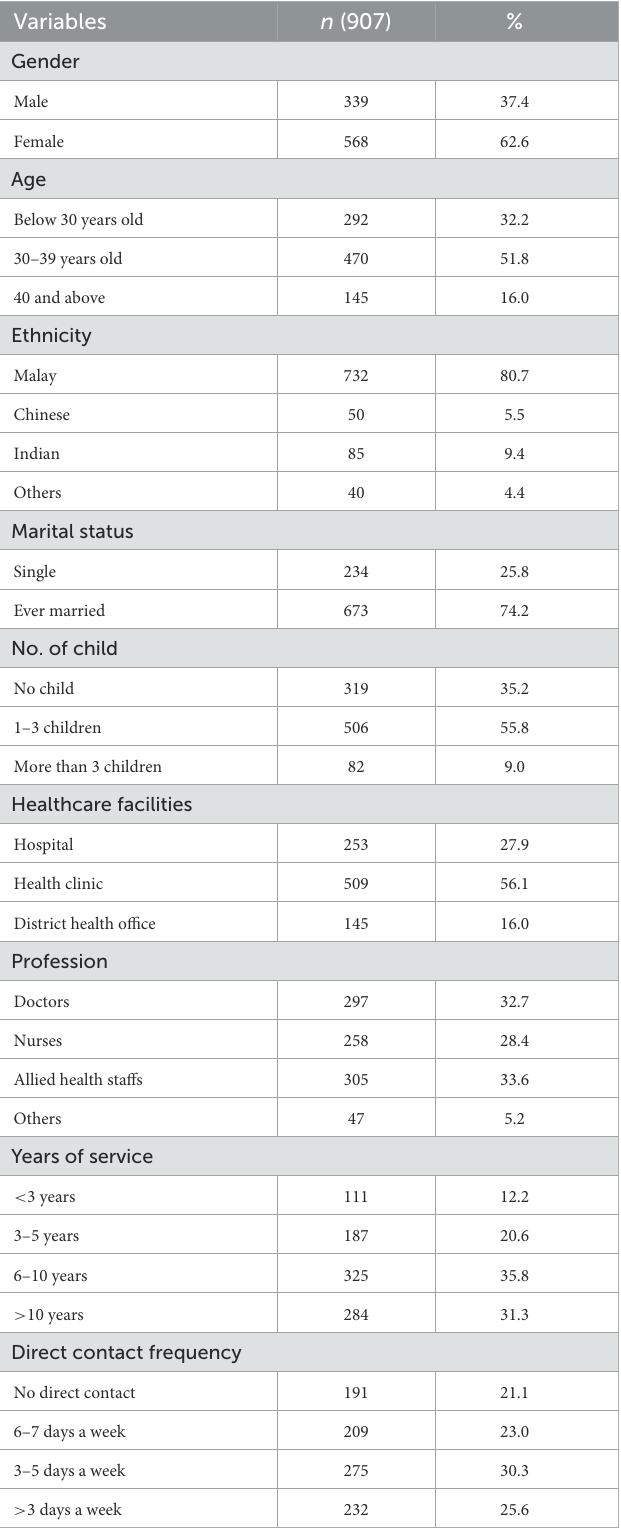
TABLE 1 Distribution of respondents based on the demographical and occupational characteristics.